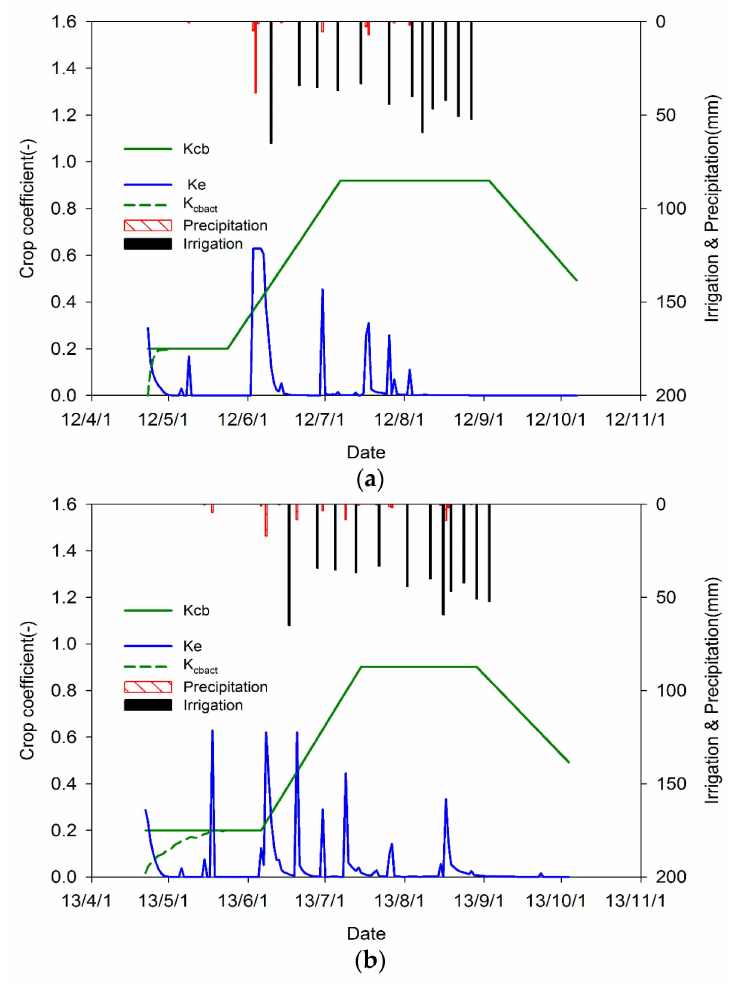
Figure 5. Seasonal variation of K cb , K cb act , K e , irrigation, and precipitation for cotton: ( a ) in calibration period (2012); and ( b ) validation period